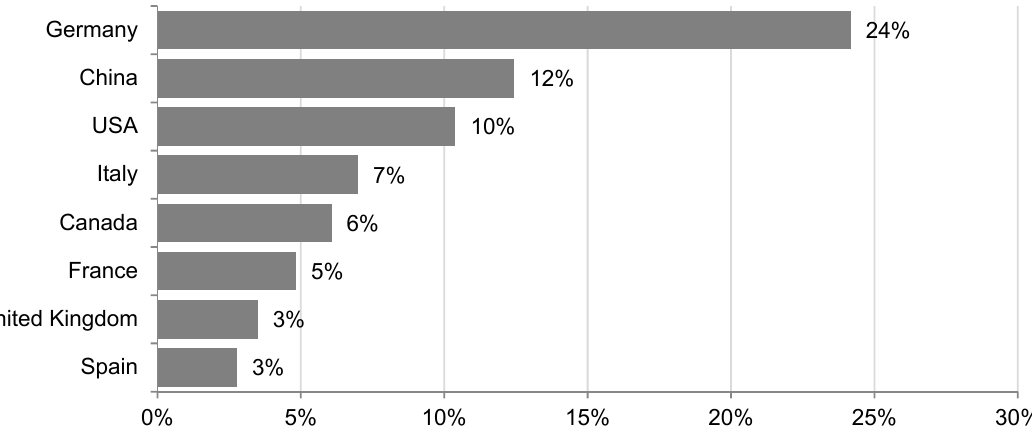
Figure 1. Countries of the principle investigator’s (PI) institutions: 955 PIs submitted proposals. All countries with more than 20 PIs were considered.